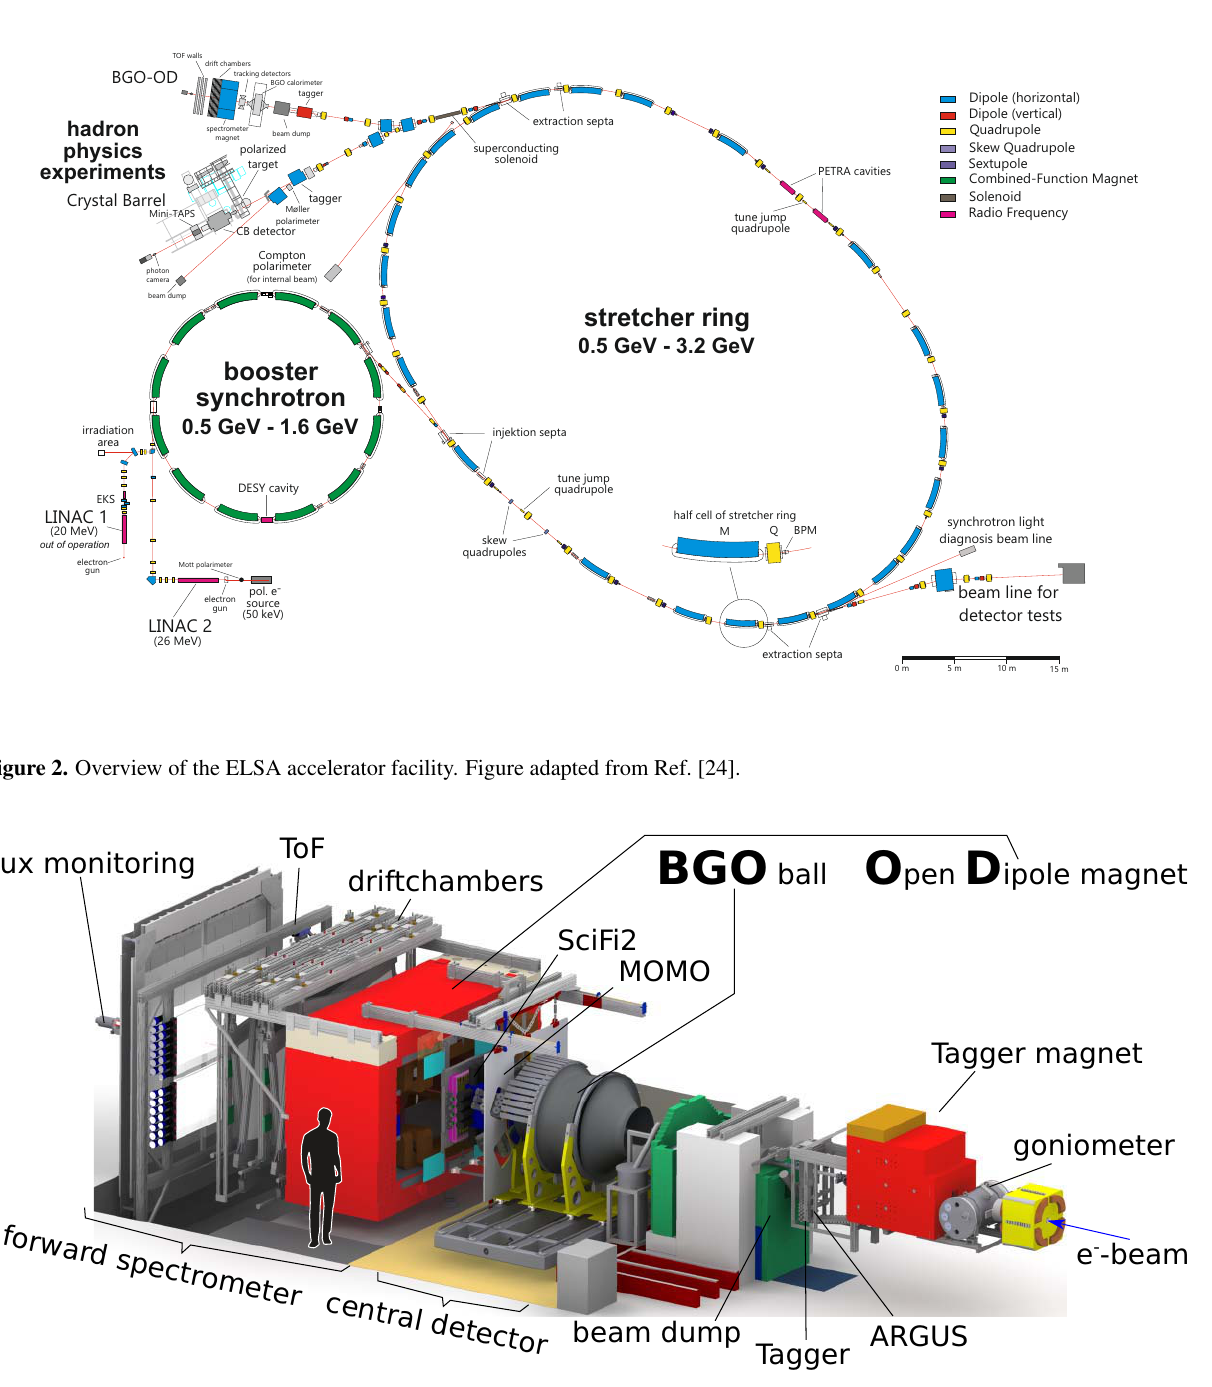
Eight double-sided drift chambers trace particle tra- jectories downstream from the magnetic field. Each drift chamber is orientated to measure either horizontal, vertical or ± 9 ◦ from horizontal information (named X,Y,U and V respectively). Using accurate three dimensional maps of the magnetic field (both measured and simulated), parti- cle trajectories and momenta are determined using com- binations of all tracking detectors, with a resolution of δ p / p ≈ 3%. Three ToF Walls measure the time of inci- dent particles relative to the reaction start time.